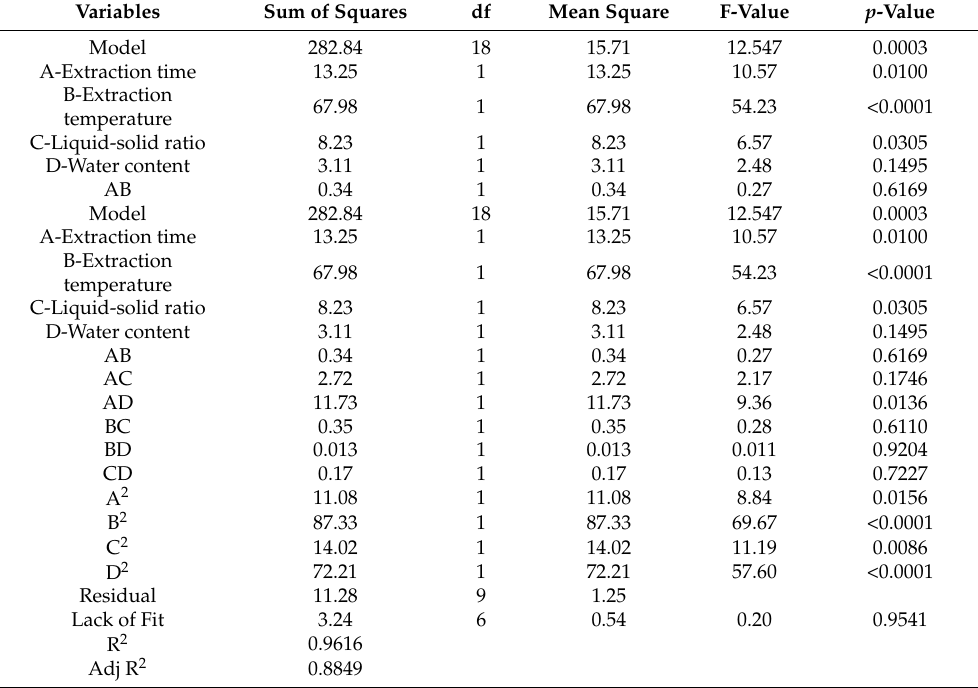
Table 3. The ANOVA of the regression